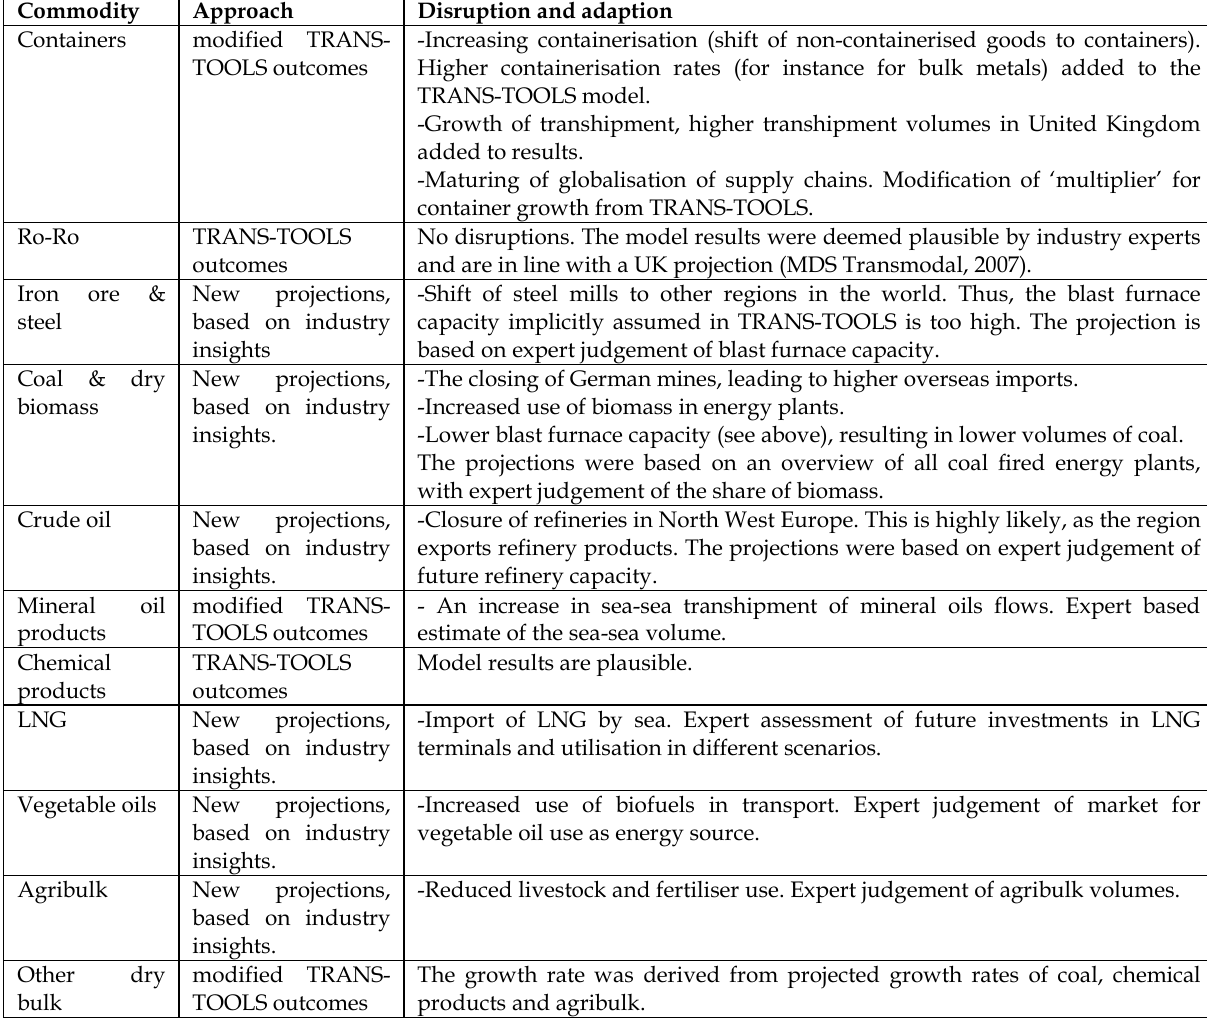
Table 4. Approach for projections for all